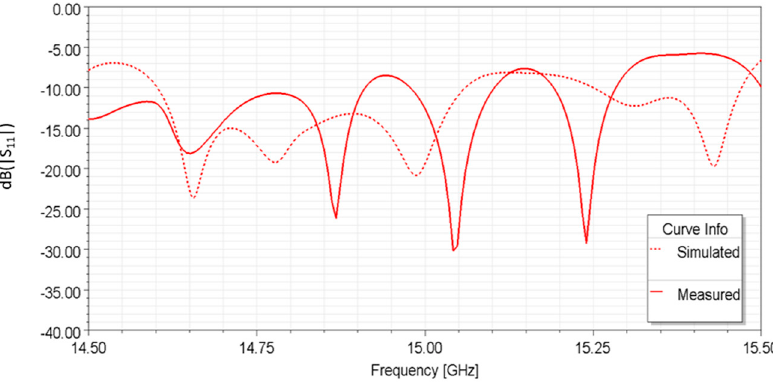
Figure 14. Simulated and measured reflection coefficients of the printed SWA array.